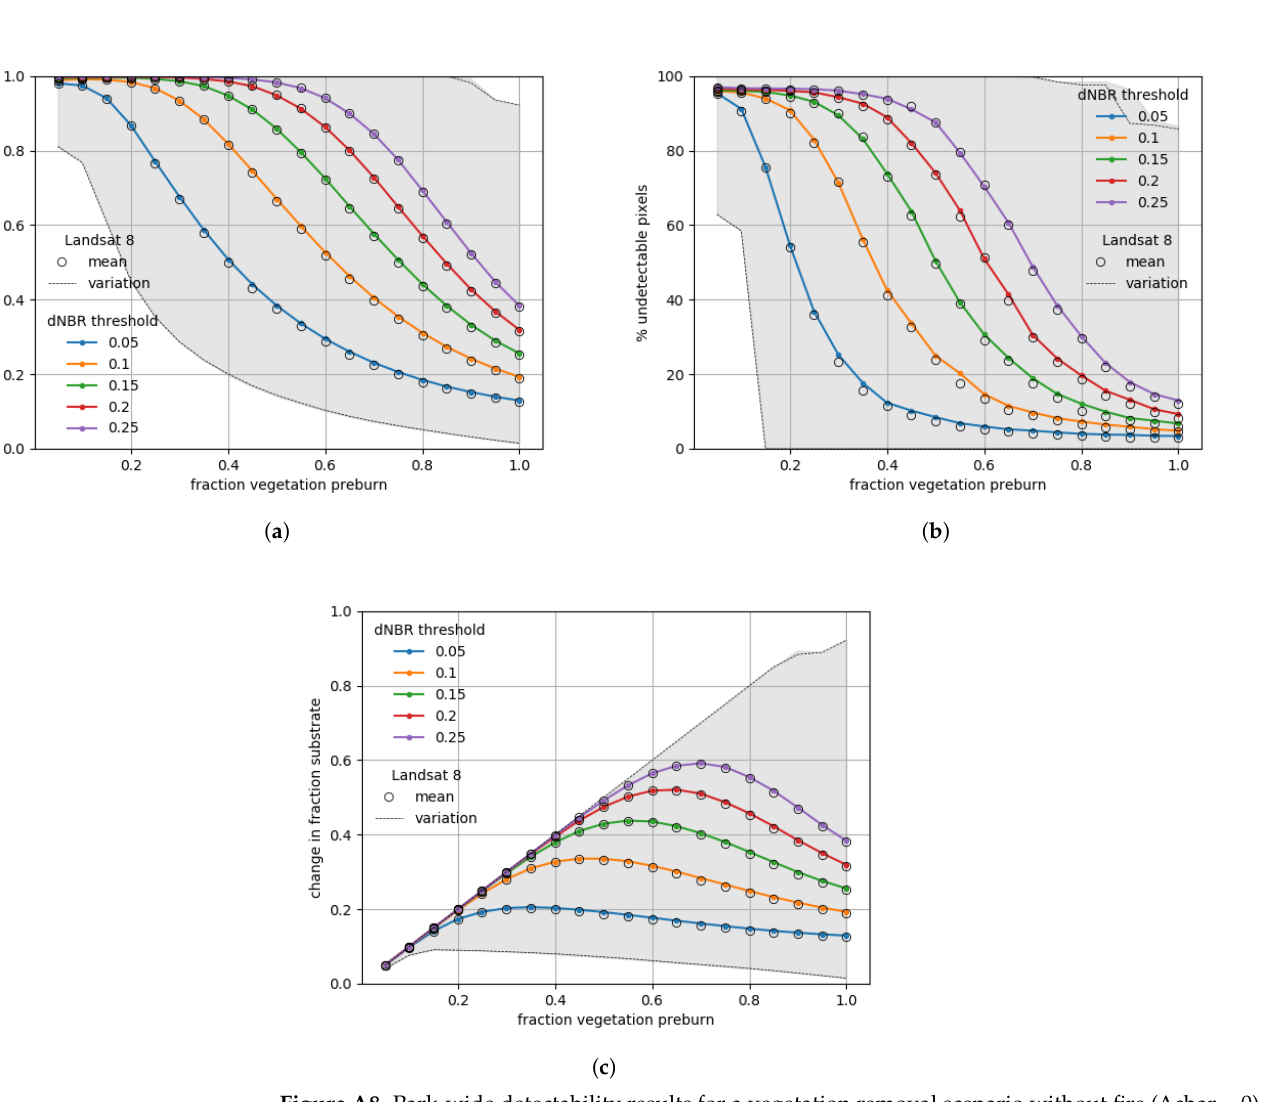
Figure A8. Park-wide detectability results for a vegetation removal scenario without fire ( ∆ char = 0), Sentinel-2B. The mean values are shown in colored lines, with total model result variation shown in gray. To compare, the results for Landsat 8 are shown in black, with mean values shown by circles and total model result variation shown by dashed lines. ( a ) Fraction of vegetation burned at detection. ( b ) Percentage of undetectable pixels. ( c ) Increase in substrate fraction on